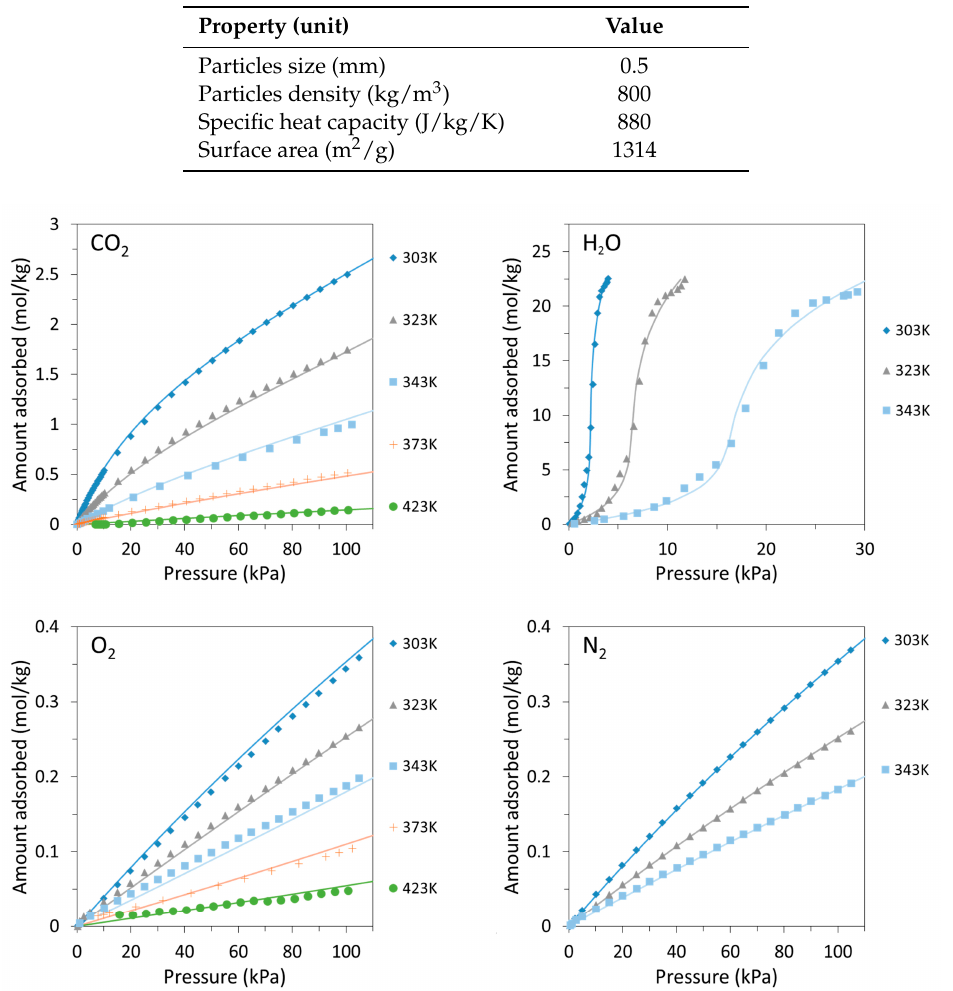
Figure 2. Adsorption isotherms of CO 2 , H 2 O, O 2 and N 2 on the activated carbon beads: experimental (dotted lines) and Virial isotherm fitting (solid lines).